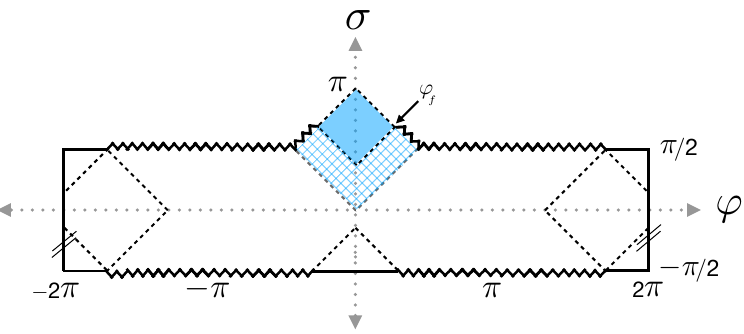
Figure 2 . Penrose diagram for dS n with n = 2 and a flat bubble centred at ϕ = 0 . The domain of 2 dependence of the part of I + on which φ → ∞ is shaded in blue, but the metric is still flat in the blue hatched